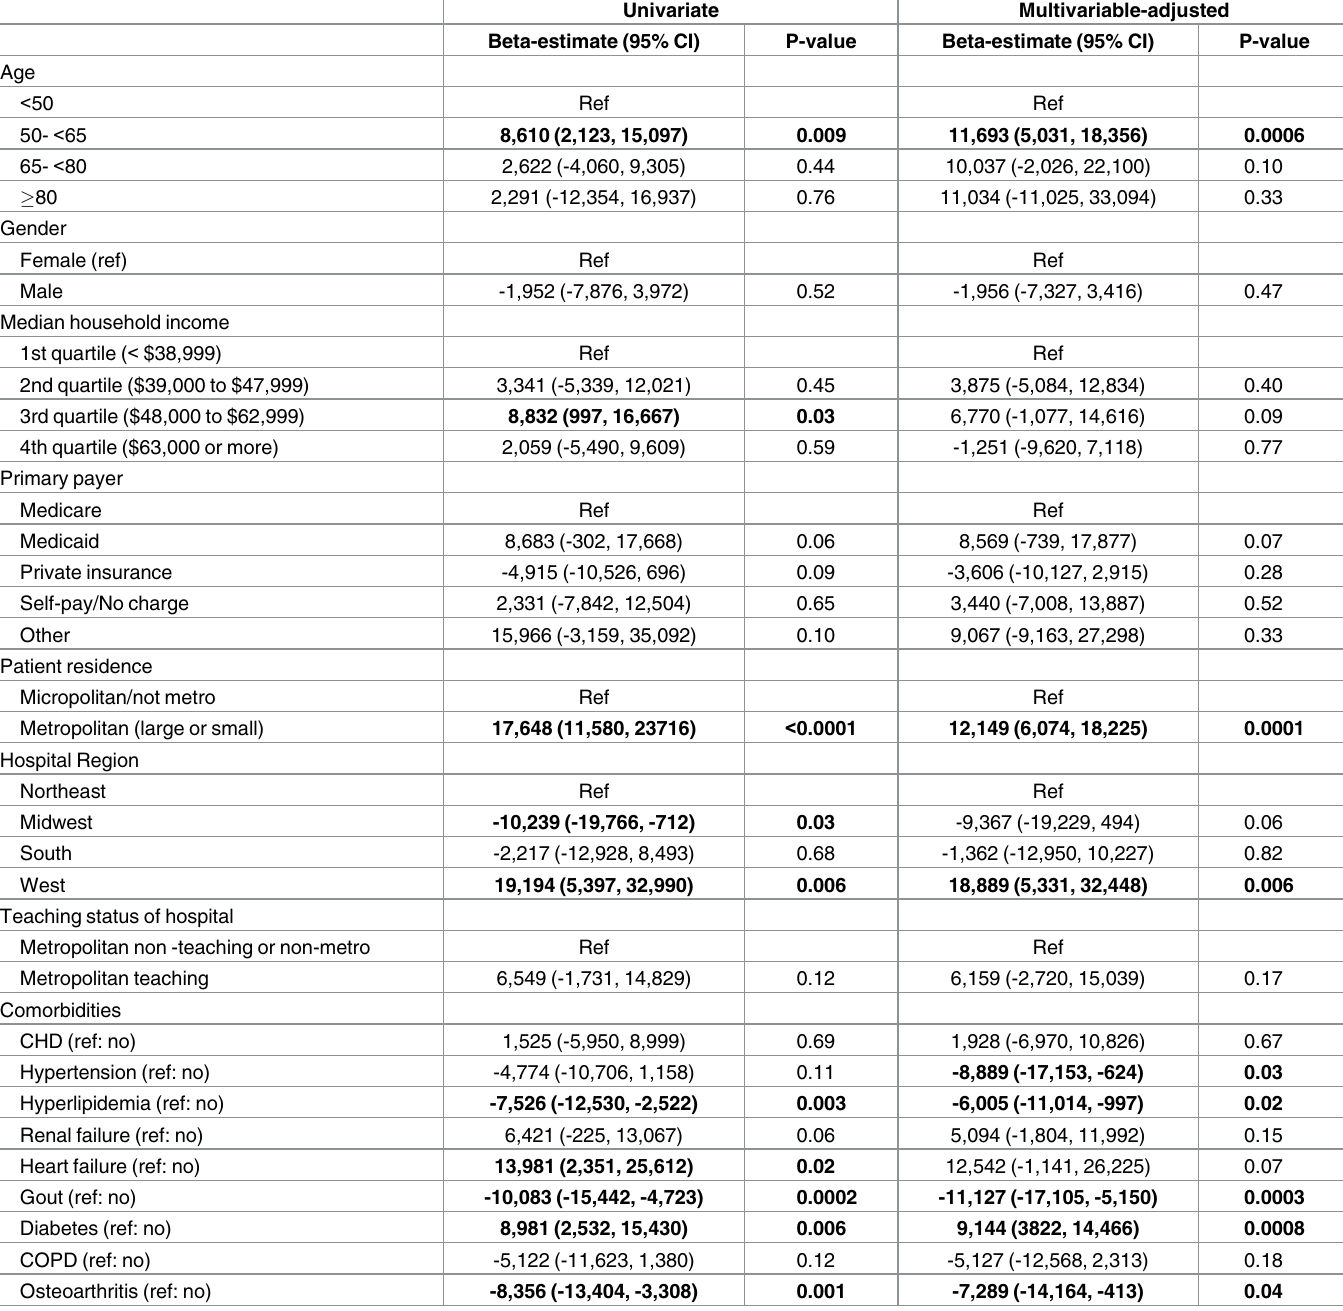
Table 5. Predictors of the total hospital charges (inpatient +ED charges) among patients with septic arthritis who had a hospital admission with septic arthritis after presenting to